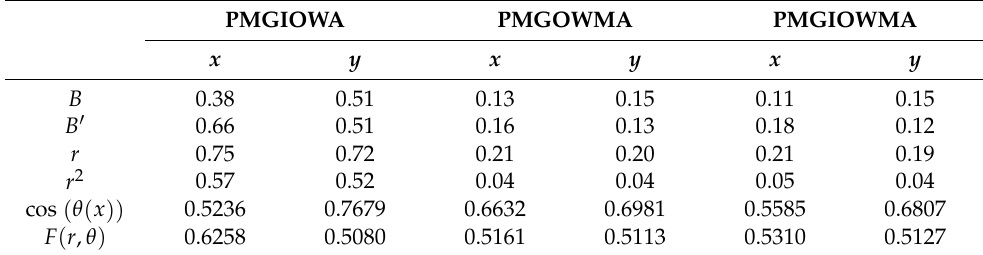
Table 1. Consolidated